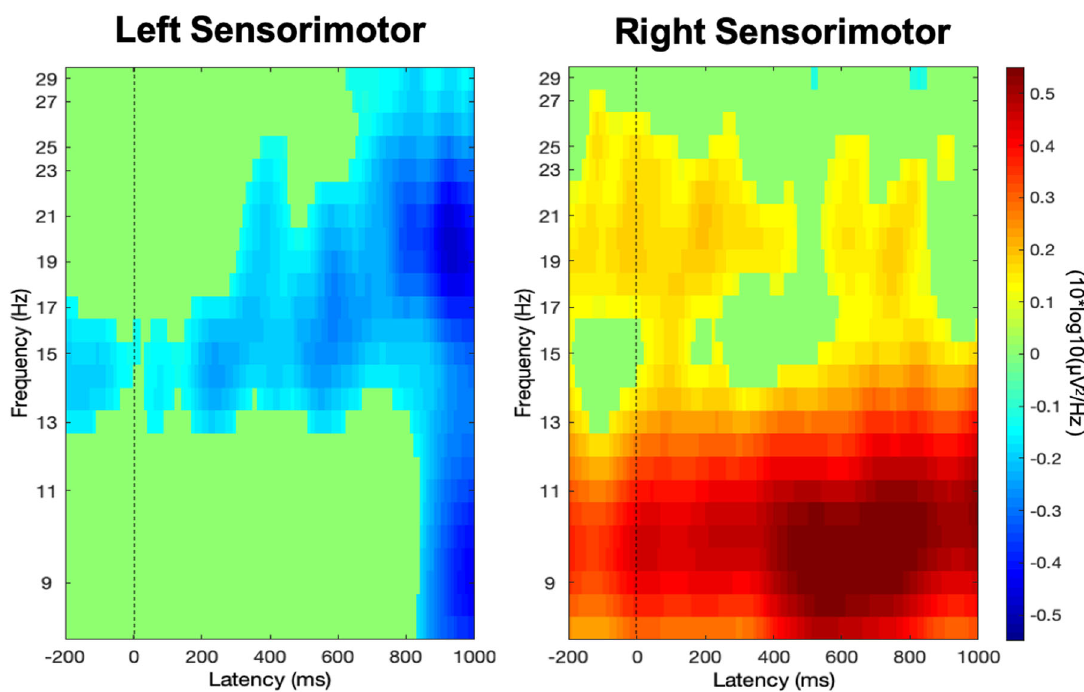
Fig. 6 Stimulus-locked EEG activity across all conditions. EEG activity across all conditions in the left and right sensorimotor clusters in the pre- and peri- stimulus time window, masked for signi fi cant differences from the baseline period at p < 0.05, FDR corrected. Stimulus onset occurs at time zero (dotted line).